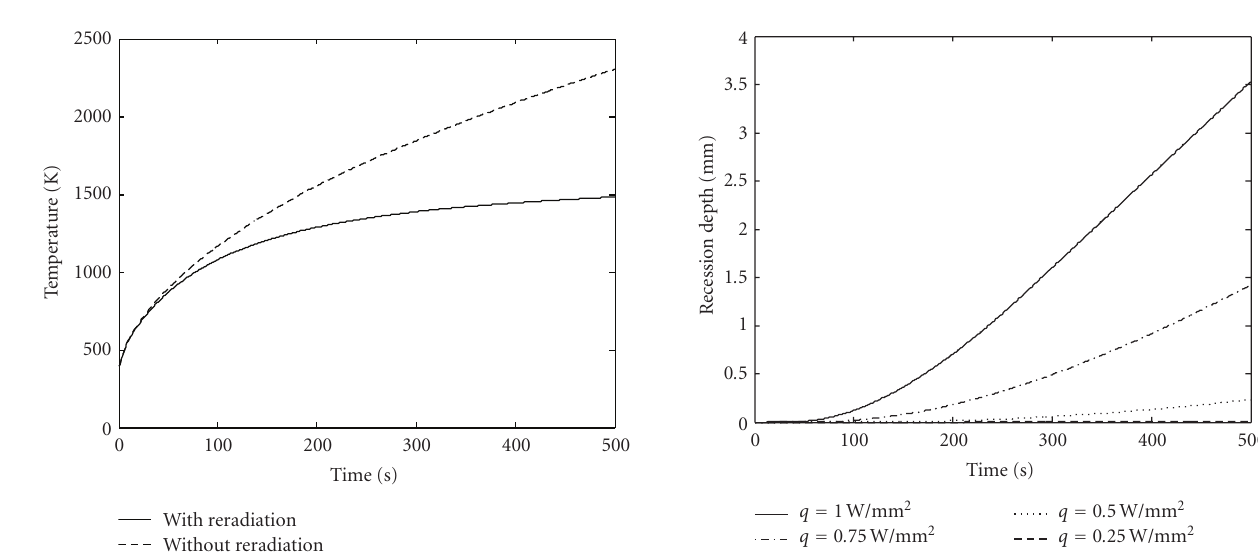
Figure 8: Surface recession with time at altitude, h = 32 . 5 km.